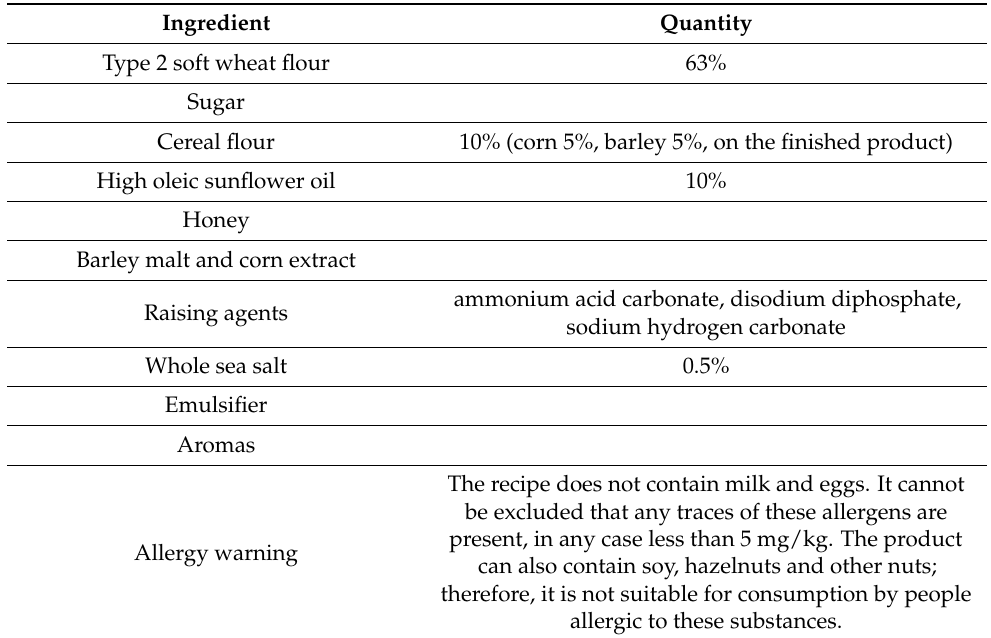
Table 1. Magretti biscuit